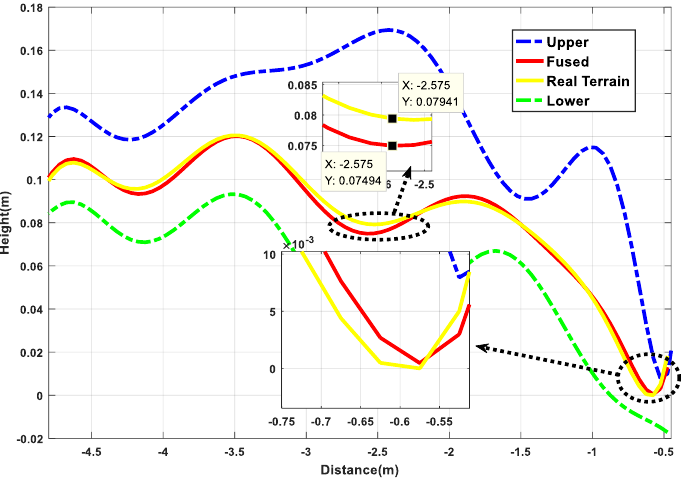
Figure 29. Terrain mapping results profile.